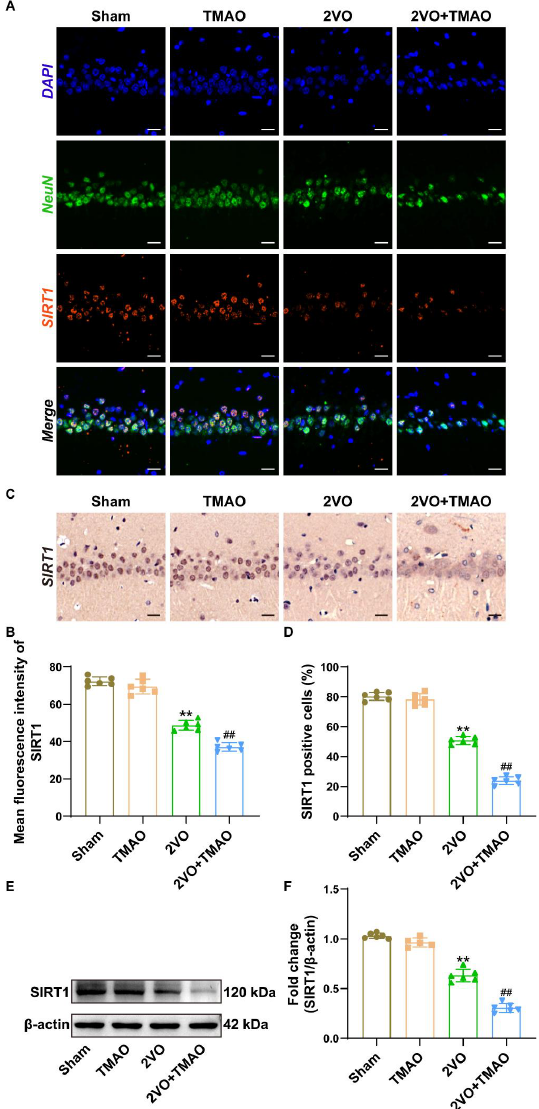
Figure 7. TMAO decreased hippocampal SIRT1 expression within 2VO rats. ( A ) Immunostaining displayed colocalization for NeuN (green) and SIRT1 (red) within the hippocampal CA1 area. Nuclei were subjected to DAPI staining. Scale bar, 20 µ m (n = 6). ( B ) Quantification for the mean fluorescence intensity of SIRT1 is shown as a bar chart (n = 6). ( C ) Imaging of the immunohistochemical staining showing SIRT1 expression within the hippocampal CA1 area. Scale bar, 20 µ m (n = 6). ( D ) Quantifi- cation for the SIRT1-positive cells is shown as a bar chart (n = 6). ( E ) Representative bands for SIRT1 protein expression within the rat hippocampi across the groups. β -actin served as a loading control (n = 6). ( F ) Quantification for SIRT1 protein expression is shown as a bar chart (n = 6). Datasets reflect the mean ± SD. ** p < 0.01 versus the Sham group; ## p < 0.01 versus the 2VO